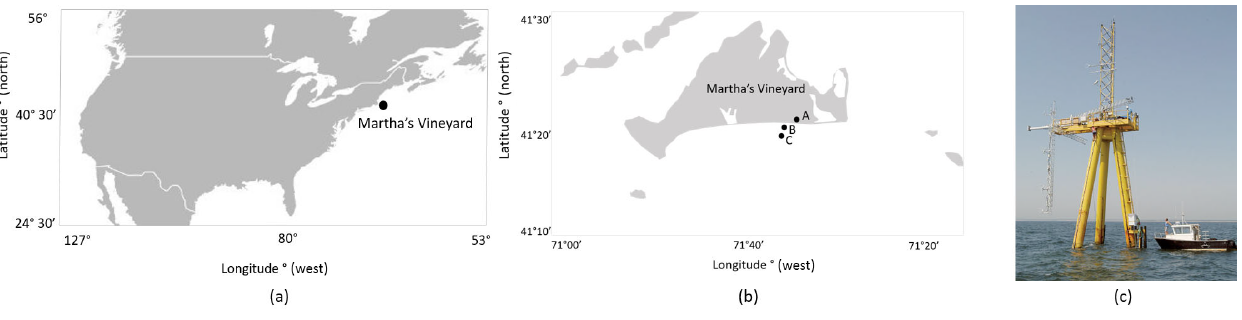
Figure 3. (a) Location of the ASIT measurement mast in the Atlantic Ocean. (b) Location of the ASIT measurement mast compared to Martha’s Vineyard. Point A is the meteorological mast, point B is a subsurface node and point C is the ASIT measurement tower. (c) ASIT measurement tower.